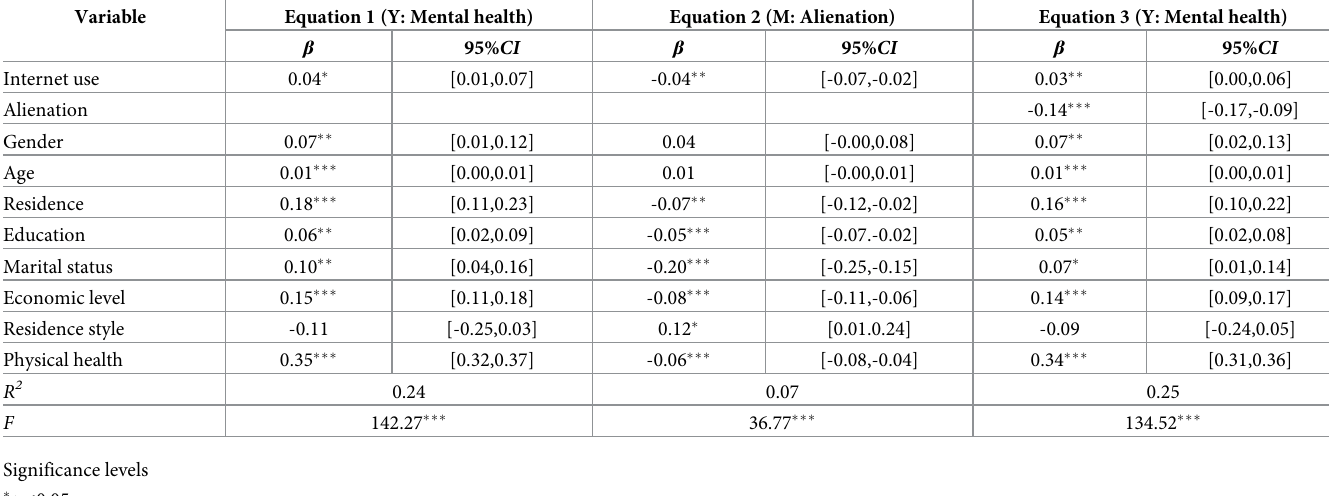
Table 4. Regression results of the relationship among Internet use, alienation and mental health of the elderly (Full sample). All variables entered the regression equation after being standardized. Variable